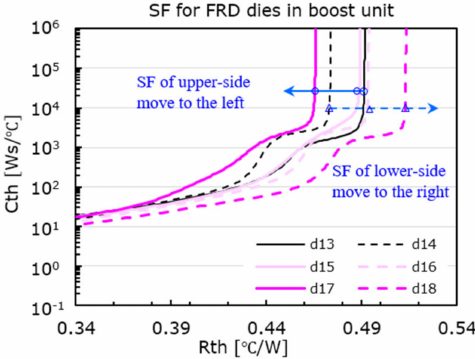
Figure 6. Comparison of partial SF curve for FRD dies of the boost unit. The solid and dashed lines represent the SFs of the upper side and lower side, respectively, while the black, light purple and purple lines are the part of SF curves for the 1st, 2nd and 3rd phases, respectively. Table 1. Comparison of R th,JL for FRD dies of the boost unit. Phase